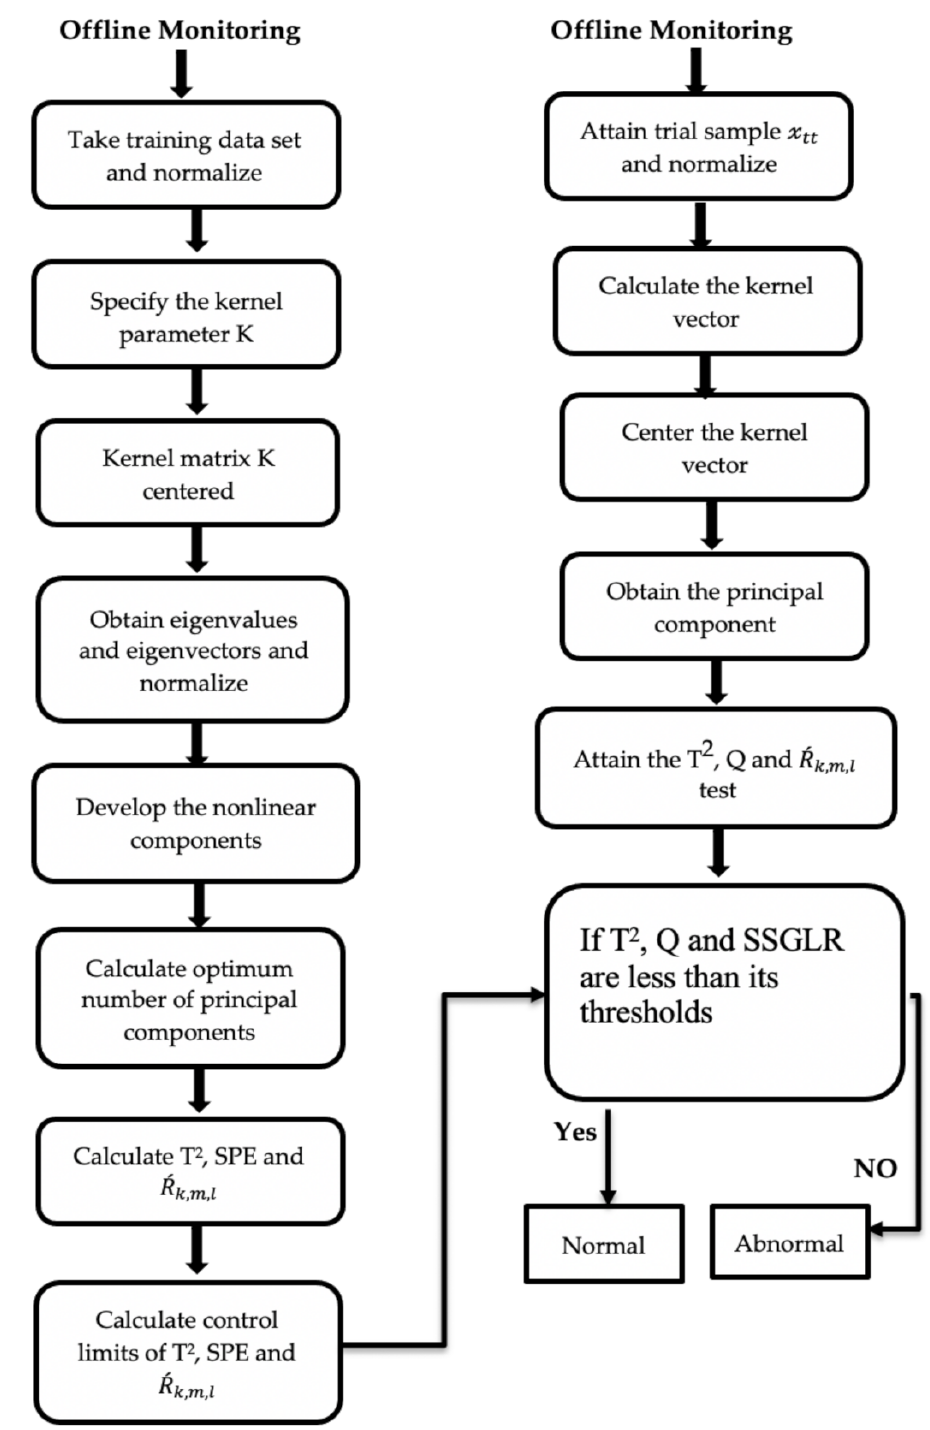
Figure 1. Flowchart of KPCA-KDE-SSGLR